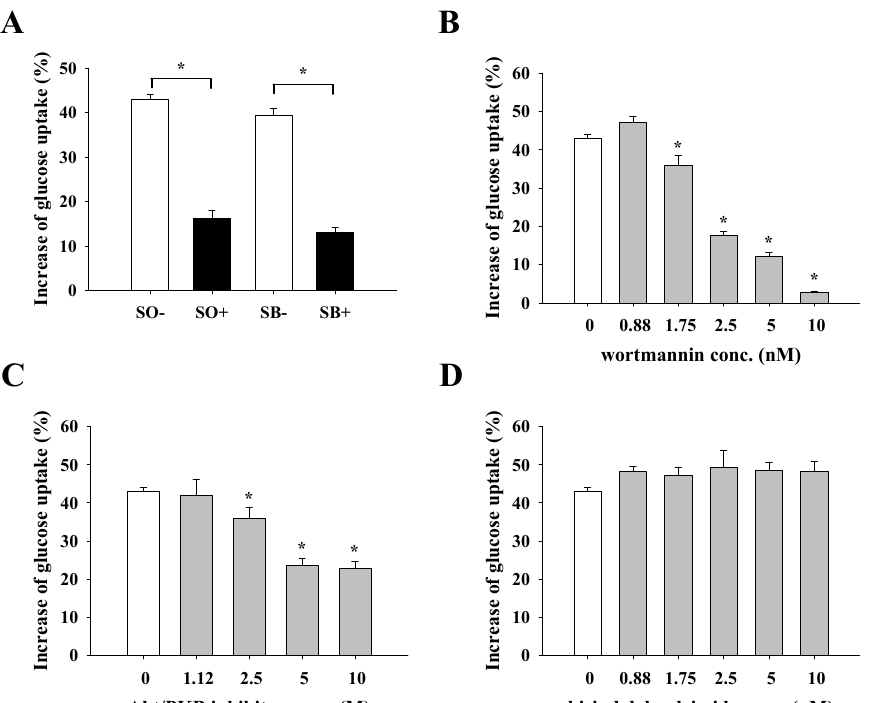
Figure 5. Impact of PTP and signal transduction protein inhibitors on hypoglycemic activity of S. pastorianus extract in 3T3-L1 cells. Pretreatment of 3T3-L1 cells with ( A ) sodium orthovanadate (SO; PTP inhibitor) and SB20358 (SB; p38 MAPK inhibitor), ( B ) wortmannin (PI3K inhibitor), ( C ) AKT/PKB inhibitor, and ( D ) bisindolylmaleimide (PKC inhibitor) for 20 min followed by S. pastorianus extract treatment for 2 h. The level of glucose in medium was determined to obtain the increased rate of glucose uptake compared to that before treatment. * p < 0.05 compared to cells treated without inhibitors.